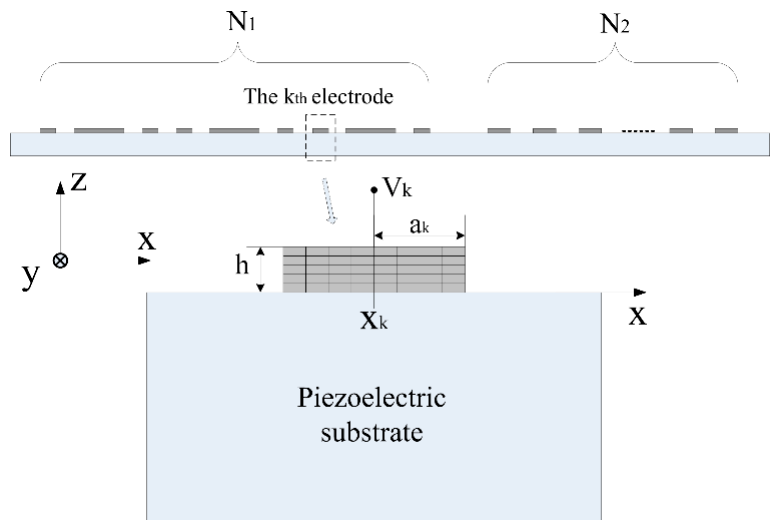
Figure 2. Schematic drawing of the electrodes array.